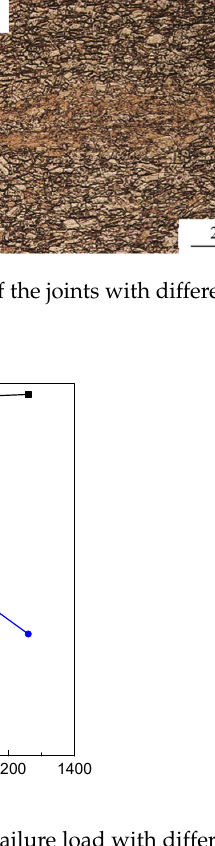
Figure 10. Tensile and peeling peak failure load with different welding forces. The ultrasonic welding process is complicated, involving not only mechanical inter- locking but also interatomic diffusion and dynamic recrystallization of crystal grains [26]. In the early stage of Cu-ETP ultrasonic welding, the welds were not directly bonded but instead partially mechanically interlocked. Due to the low welding heat input or low welding force, the welding energy between the interfaces is insufficient. Under the action of an external force, the connecting surfaces squeeze and cause friction on one another to form a mechanical interlock. Mechanical interlocks are usually jagged. This type of inter- locking is only macroscopic mechanical interlocking, and it is easy to detach under the action of an external force, so the tensile load and peeling load of this joint are relatively low. As the welding energy or welding force increase, the mechanical interlock will grad- ually decrease. This shows that mechanical interlocking is not the main connection mech- anism of copper ultrasonic welding. Under the action of static pressure and high-frequency vibration, the interface tem- perature of the joint increases rapidly. When the energy acquired by the atom is greater than its activation energy for diffusion, the atom diffuses, and the metal atoms interact to form a bond. Metal bonding enhances the mechanical properties of welded joints. This shows that metal bonding plays a key role in the ultrasonic welding of Cu-ETP. The grain boundary misorientation angle is less than 5° as indicated by the green line in Figure 11, and the grain boundary misorientation angle is greater than 5°, as marked by the black line in Figure 11. Figure 11a,b shows that the quantity of small-angle grain boundaries increases significantly after welding. The fraction of grain boundary misorientation dis- tribution in Figure 11c,d also shows this trend. These results lie in the plastic deformation of the welded joint during the welding process, which leads to an increase in the disloca- tion density. The welding process increases the temperature of the substrate, which leads to the climbing of ductile dislocations and the cross-slip of screw dislocations. The dislo- cations gradually evolve into multilateral structures and then develop into small-angle grain boundaries. From the grain distribution of Cu-ETP welded joints with the optimal 600